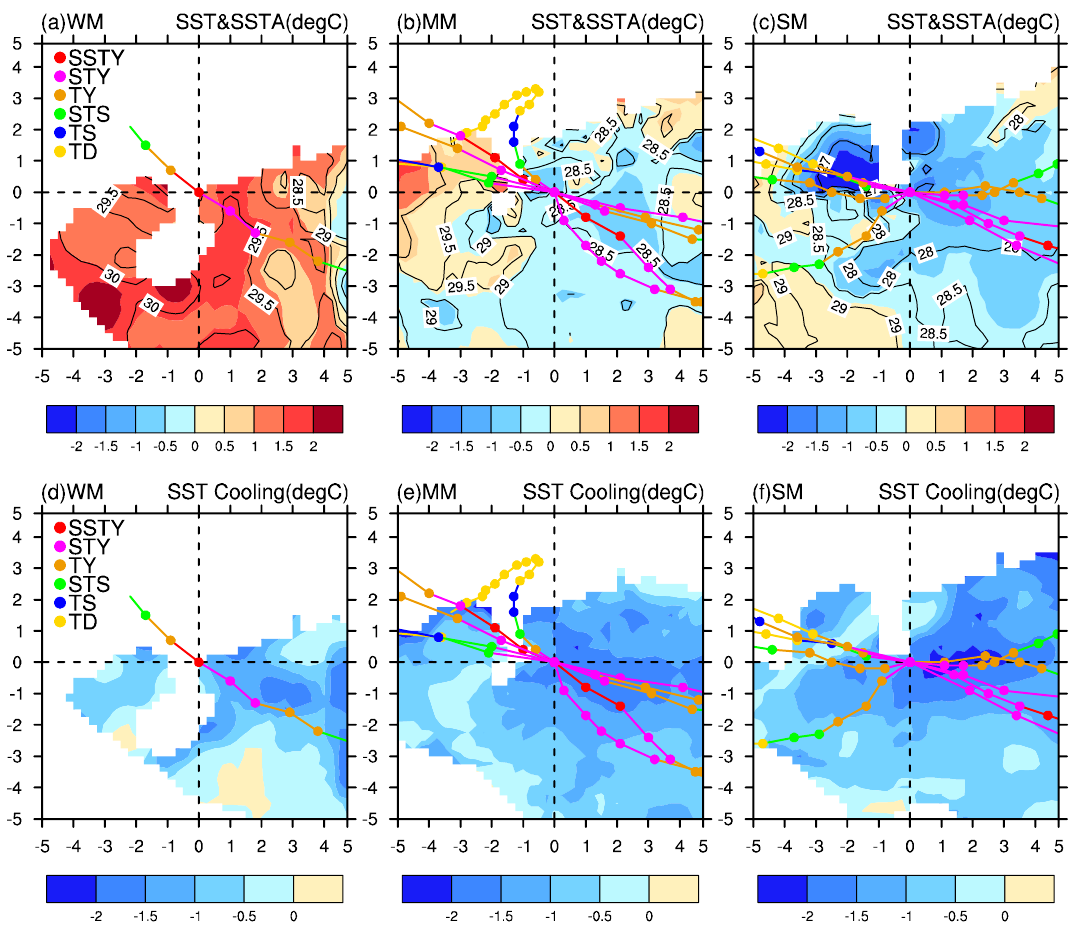
Figure 10. Dynamic composites of the SST ( a – c , contour) and SSTA ( a – c , shaded) at the landfall day and amplitudes of the SST cooling ( d – f ) at the offshore area. The corresponding TCs tracks are shown in curves and circles. The origin coordinates (0, 0) indicate the landfall position. Vertical and horizontal coordinates are the north–south and west–east direction in degrees, respectively. ( a , d ) Cluster WM, ( b , e ) cluster MM, and ( c , f ) cluster SM. Units: ℃.